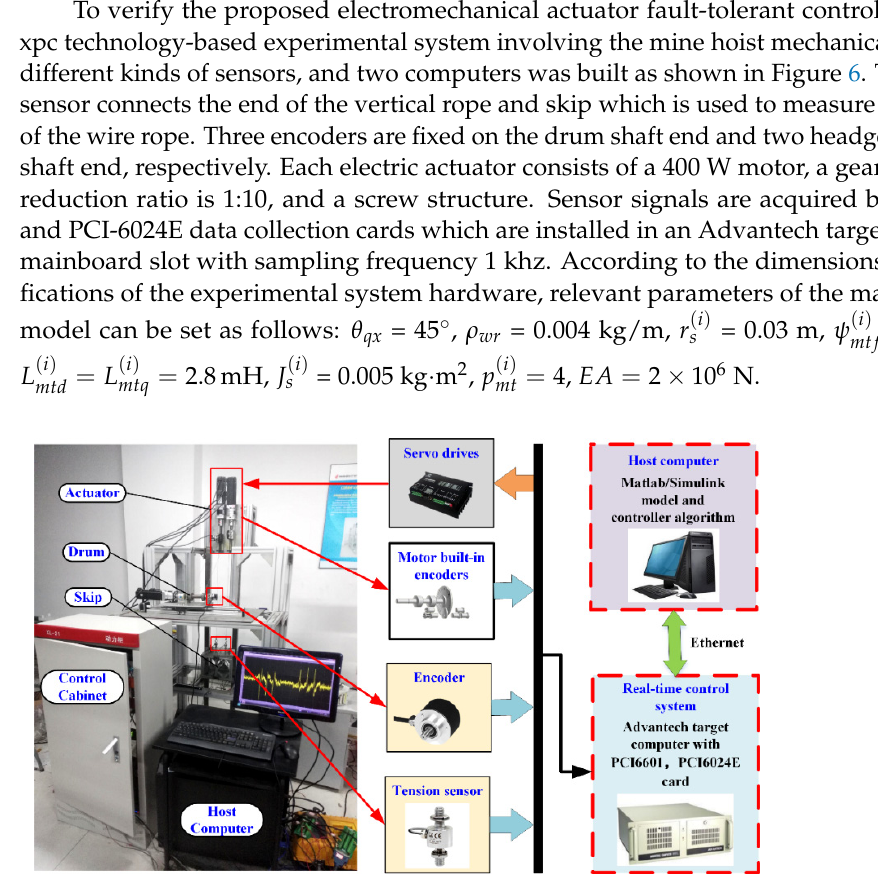
Figure 6. xpc-based mine hoist platform.